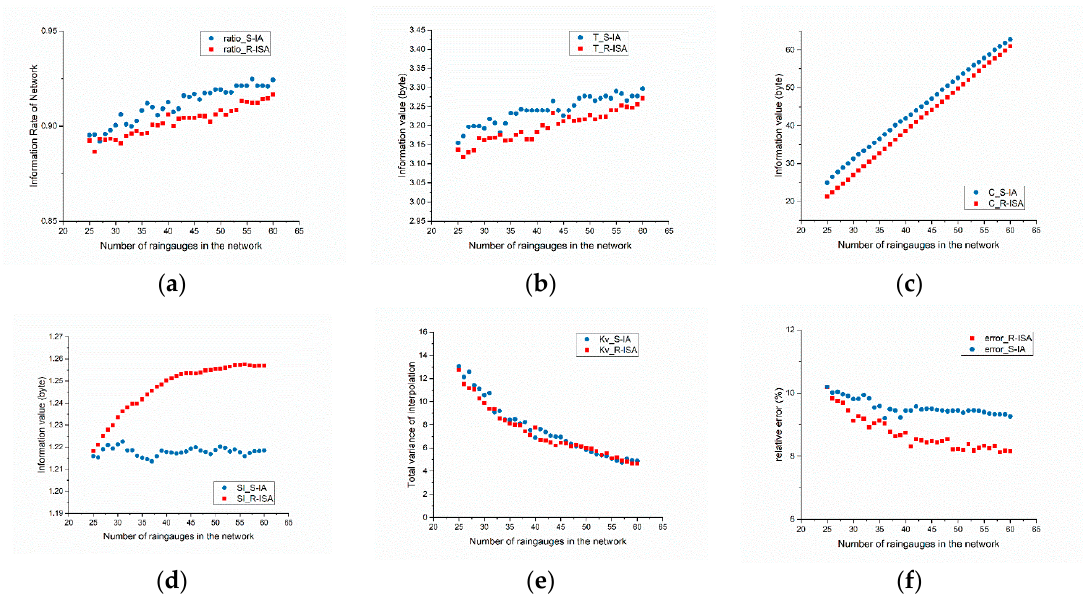
Figure 14. Comparison of the R-ISA and S-IA methods. ( a ) Statistical diagram of the percentage of joint